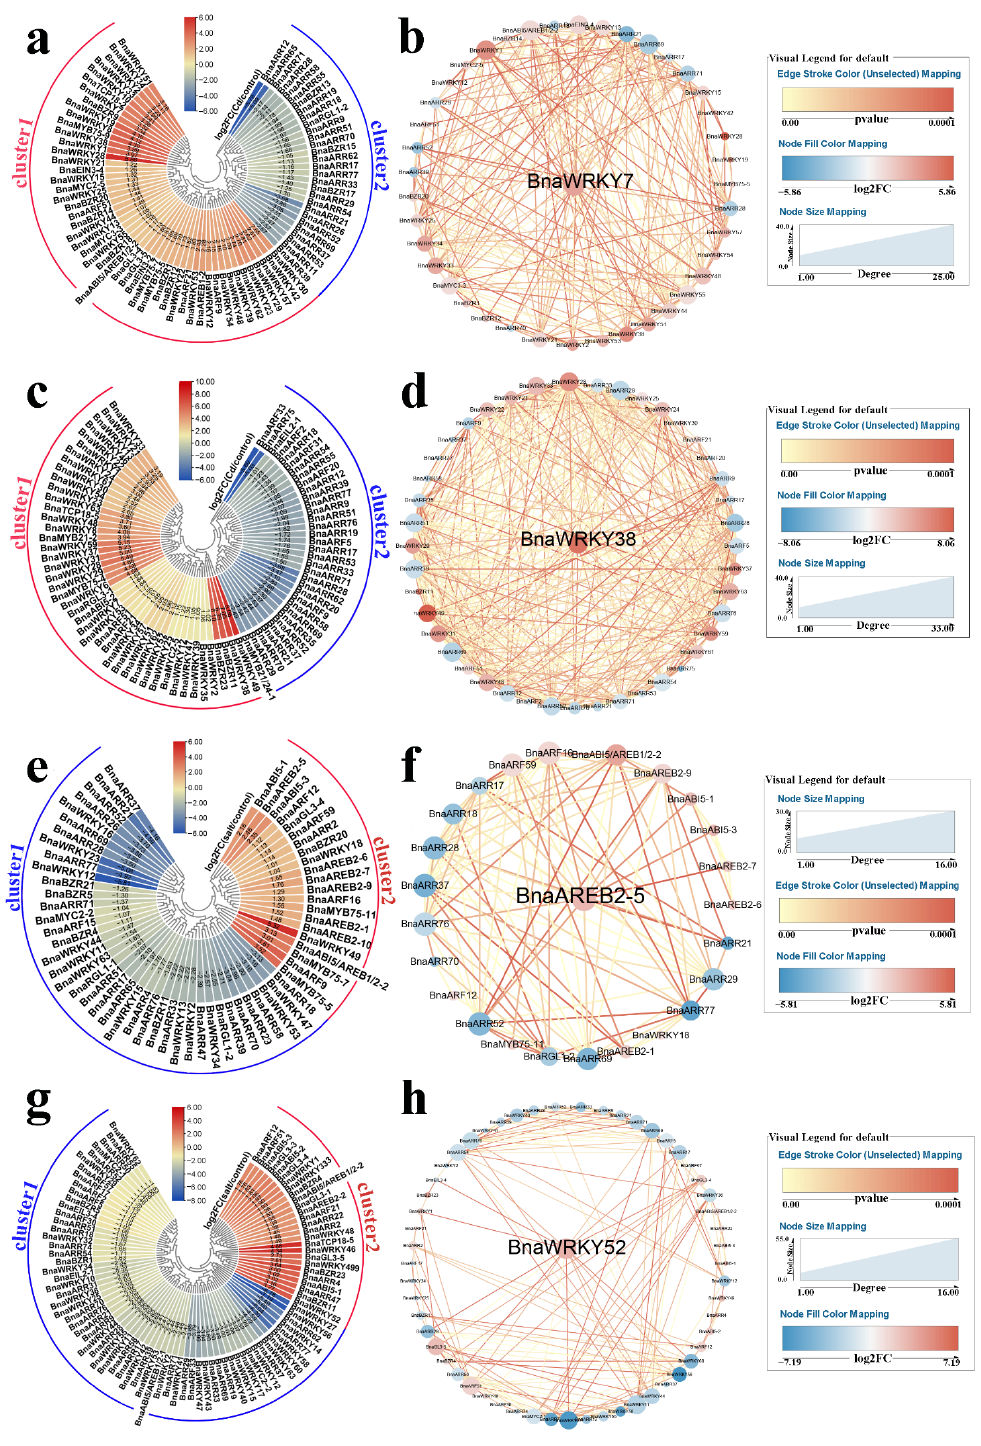
Figure 1. Expression profiles of B. napus hormone-related TFs in response to Cd and salt toxicity. Cycle nodes represent genes and the size of the node represents the power of the inter-relationship among nodes by degree value; Color of the node represents log2FC value; Red indicates up-regulated genes and blue indicates down-regulated genes; Edges between nodes represent p -value. ( a ) Expression analysis of B. napus hormone-related TFs in response to Cd toxicity in shoots. ( b ) Co-expression